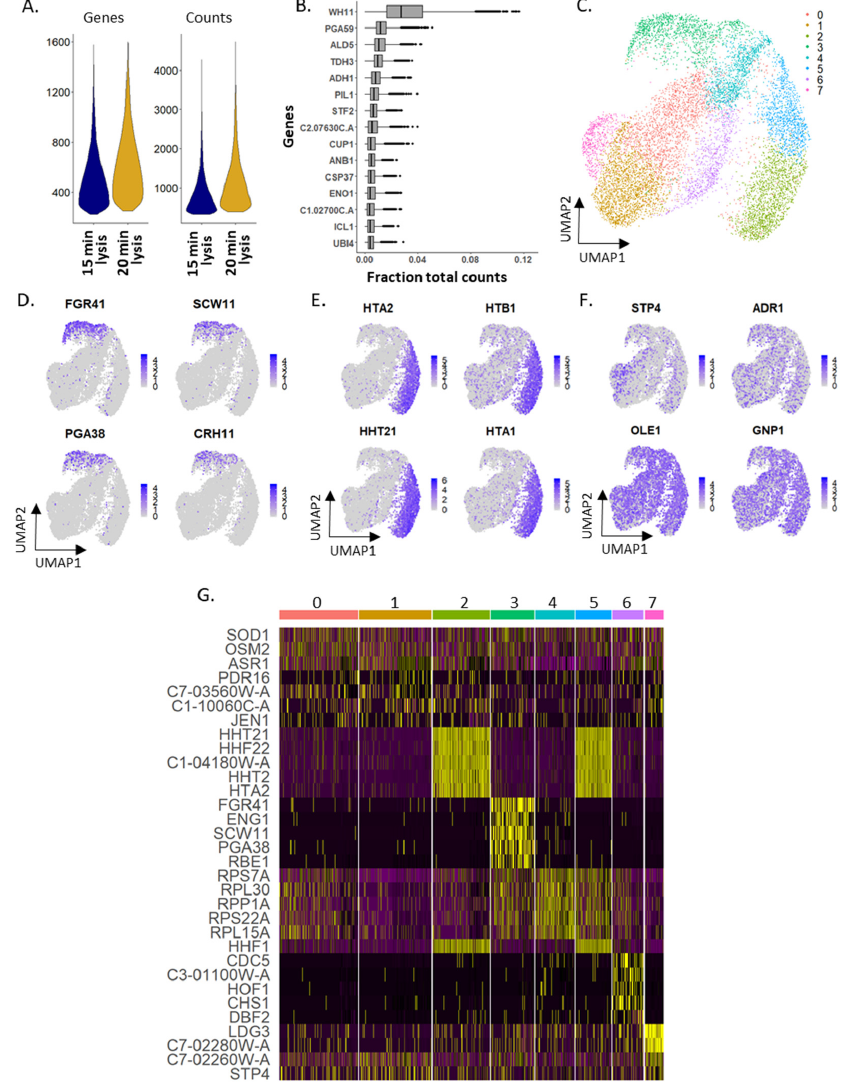
Figure 3. mDrop-seq of 10,314 Candida albicans cells, replicate 2. ( A ) Violin plots of genes and UMI counts per cell. ( B ) Boxplot of 15 genes with highest expression in C. albicans , plotted by fraction of total counts. ( C ) UMAP displaying the clustering analysis of 10,314 C. albicans cells after batch correction. ( D – F ) Feature plots displaying: ( D ) GPI-anchored cell wall proteins that represent markers for cluster 3, ( E ) histone tail genes that represent markers for clusters 2 and 5, ( F ) genes for transcription factors, fatty acid biosynthesis, and hyphal formation involved with C. albicans virulence. ( G ) Heatmap displaying expressions of the top marker genes for each cluster.